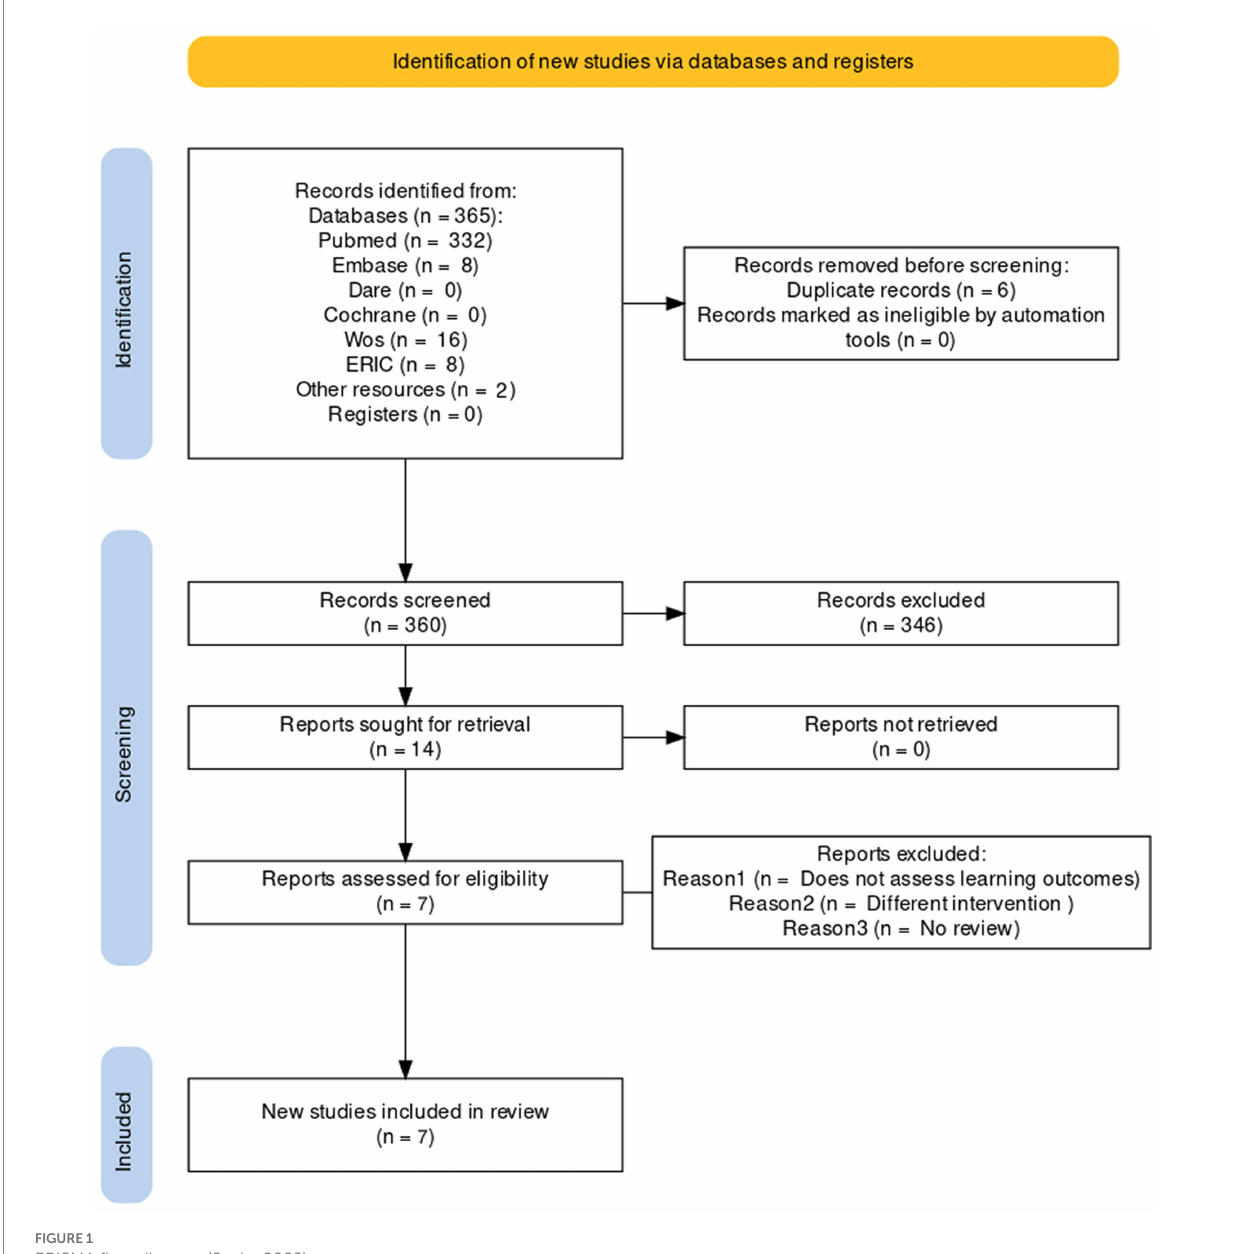
FIGURE 1 PRISMA flow diagram (Spain,